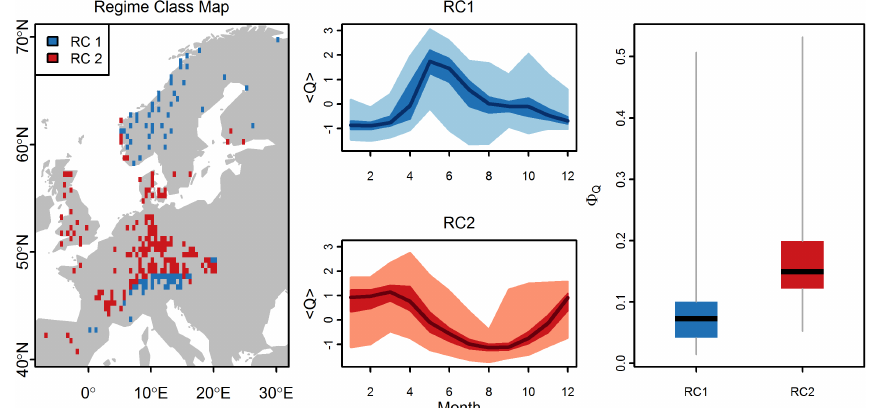
Fig. 4. Effect of the hydroclimatic regime on 8 Q , the fraction of low-frequency variance of runoff. RC1: Snow dominated regime (winter minimum–summer maximum). RC2: evapotranspiration dominated regime (summer minimum–winter maximum). The map shows the geographical domain of each regime class. The two central panels show the average shape of each hydroclimatic regime; dark line: median, dark shaded area: inter-quartile range, light shaded area: range; ( <Q> denotes standardisation of runoff). The boxplots show the difference of 8 Q between the two hydroclimatic regime classes (RC1 and RC2). Black horizontal line: median, the box covers the interquartile, the grey whiskers range from the minimum to the maximum